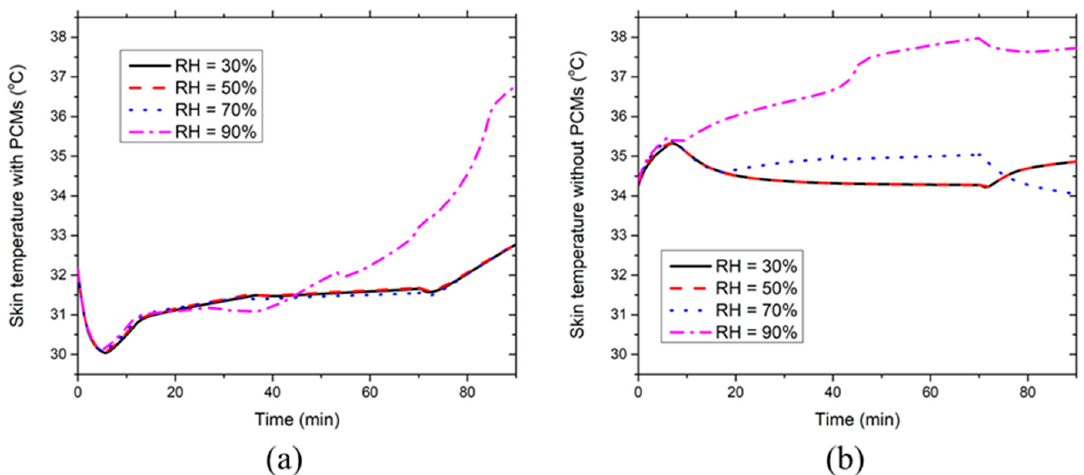
Figure 8. Effect of environmental RH on the time course of chest skin temperatures ( a ) with and ( b ) without PCMs and insulation layers at the ambient temperature of 36 °C.